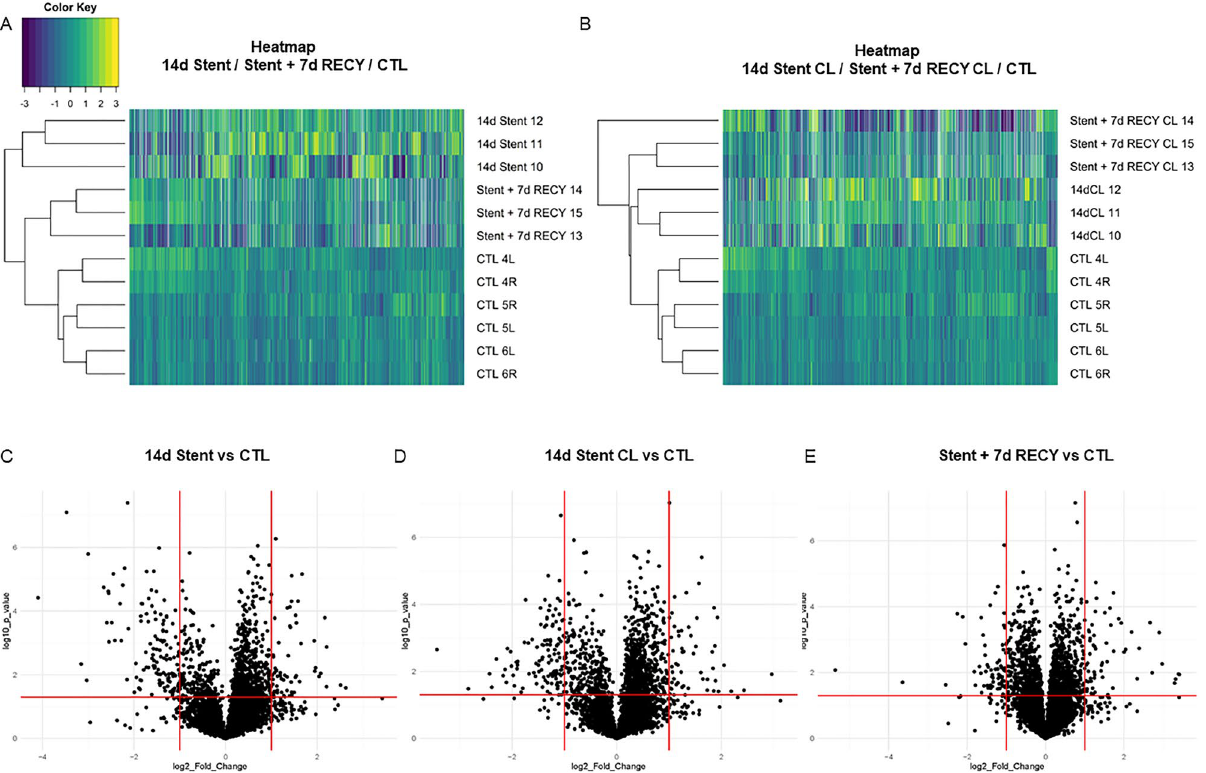
Figure 7. Proteomic analysis of stented, contralateral and control ureters. ( A ) Heatmap showing different protein expression patterns of ureters stented for 14 days (14d Stent), stented for 14 days followed by 7 days of recovery (Stent + 7d RECY) and control ureters (CTL). Proteins with more than 6 or more missing values were deleted (n = 5114). ( B ) Heatmap showing different protein expression of contralateral ureters from pigs stented for 14 days (14d Stent CL), stented for 14 days followed by 7 days of recovery (STENT + 7D RECYCL) and control ureters (CTL). Proteins with more than 6 or more missing values were deleted (n = 5115). ( C–E ) Volcano Plots showing proteins differentially expressed between 14d Stented vs CTL ( C ), Stent + 7d RECY and CTL ( D ), and 14d Stent CL versus CTL ( E ). Proteins with significant down- and upregulation are shown in the top left and top right quadrant. Significance was defined as p < 0.05 and at least twofold